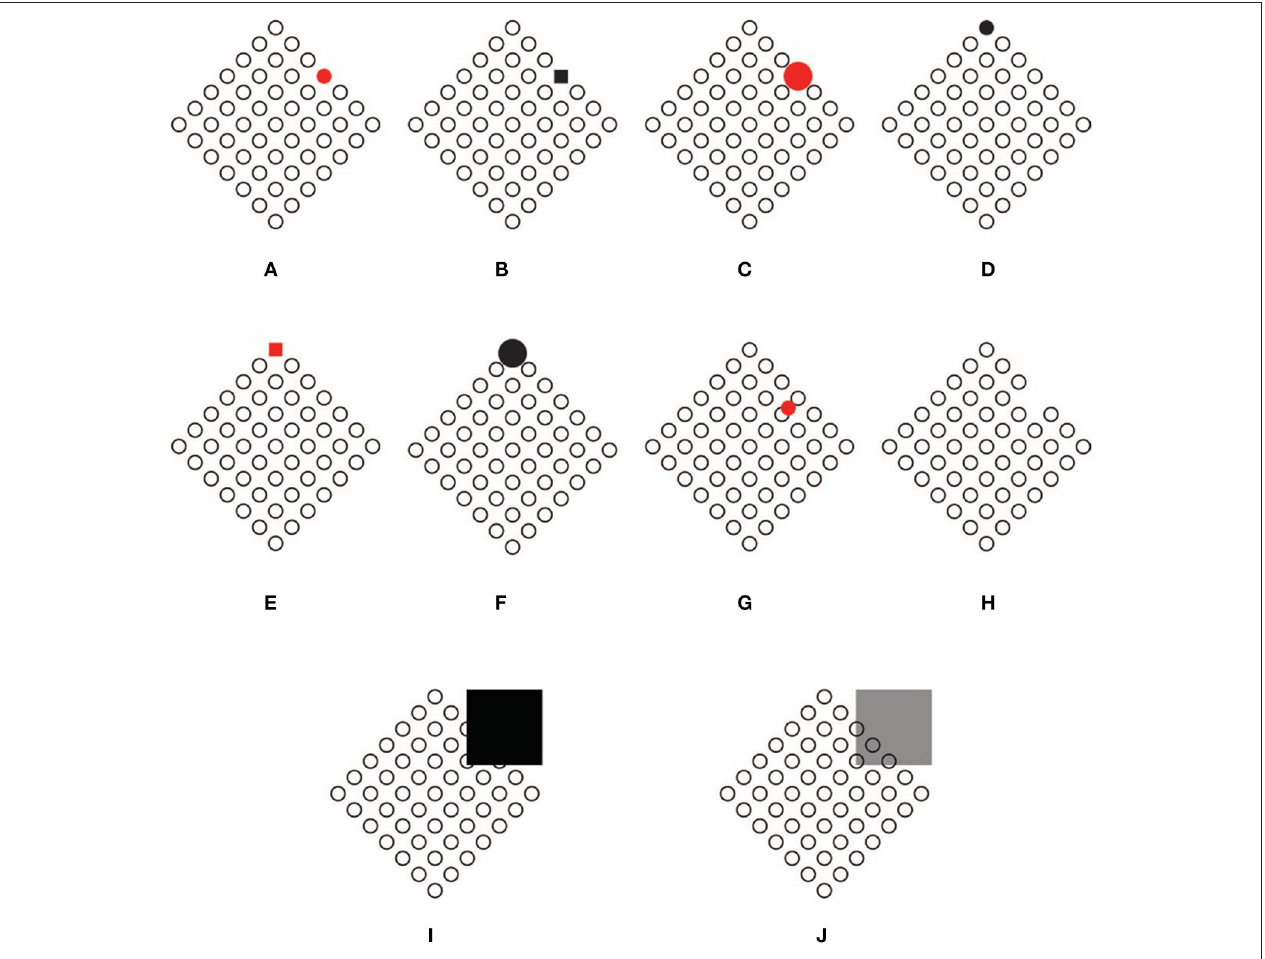
FIGURE 6 | Grouping organization changes its strength as the salience of the dissimilar element changes. The location of the dissimilar accent affects the grouping of element in the direction of the upper right side (A–C) . The location of the dissimilar accent affects the grouping of element in the direction of the upper angle (D–F) . The dissimilar accent is introduced within the group of empty circles (G) , as a gap (H) , as an amodal completion of part of the whole array of circles (I) , as an overlapping transparent layer (J) .